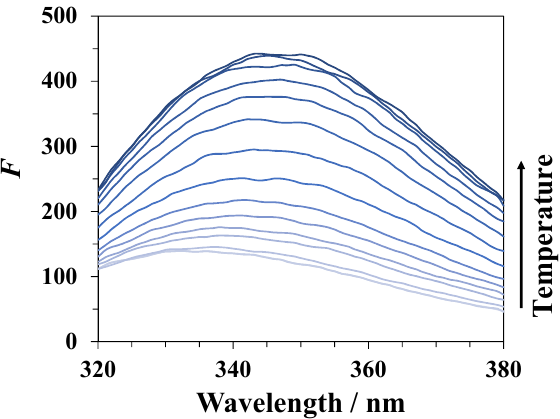
Figure 4. Changes in the emission spectrum of lysozyme with increasing temperature in a DMSO–water mixture with a DMSO mole fraction x 1 = 0.30. The excitation wavelength is 280 nm.